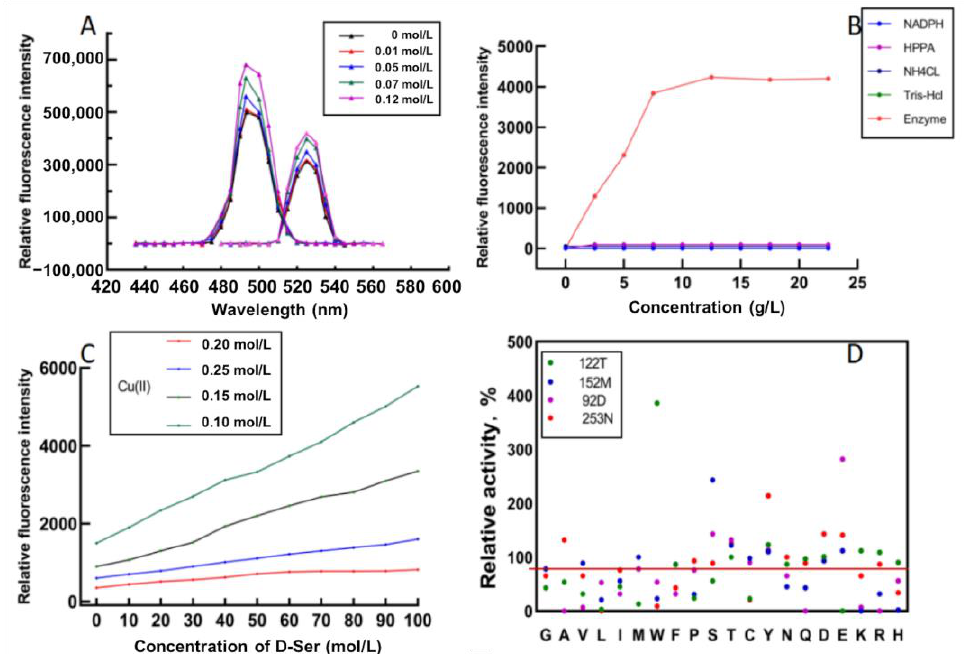
Figure 3. High-throughput screening of the mutants with Cu(II) calcein complex. ( A ) Excitation (left) and emission (right) wavelengths of Cu(II) calcein complex in the absence and presence of D-serine. ( B ) Fluorescence intensities for different concentrations of HPPA, NADPH, NH 4 CL, Tris-HCl, and enzyme. ( C ) Fluorescence intensities of different concentrations of D-serine and Cu(II) at the same enzyme concentration (2 g/L) and calcein concentration. ( D ) Relative activities of the screened mutants. Table 1. Specific activities of StDAPDH/H227V and the mutants toward hydroxypyruvate.